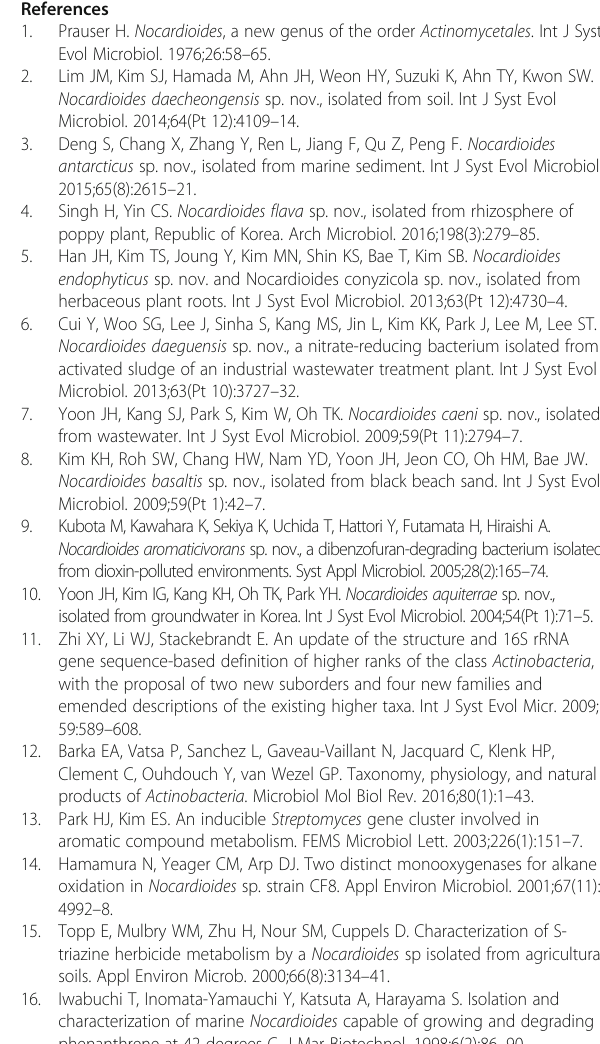
Abbreviations BLAST: Basic Local Alignment Search Tool; CDS: Coding sequence; COG: Clusters of Orthologous Groups; CRISPR: Clustered regularly interspaced short palindromic repeat; DSHA: 3-Hydroxy-5,9,17-trioxo-4,5:9,10- disecoandrosta-1(10),2-dien-4-oate; HIP: 9,17-Dioxo-1,2,3,4,10,19- hexanorandrostan-5-oic acid; KEGG: Kyoto Encyclopedia of Genes and Genomes; MIGS: Minimum information about a genome sequence; NR: Non-redundant; Pfam: Protein families; RPS-BLAST: Reversed position specific-BLAST; Uniref: UniProt reference